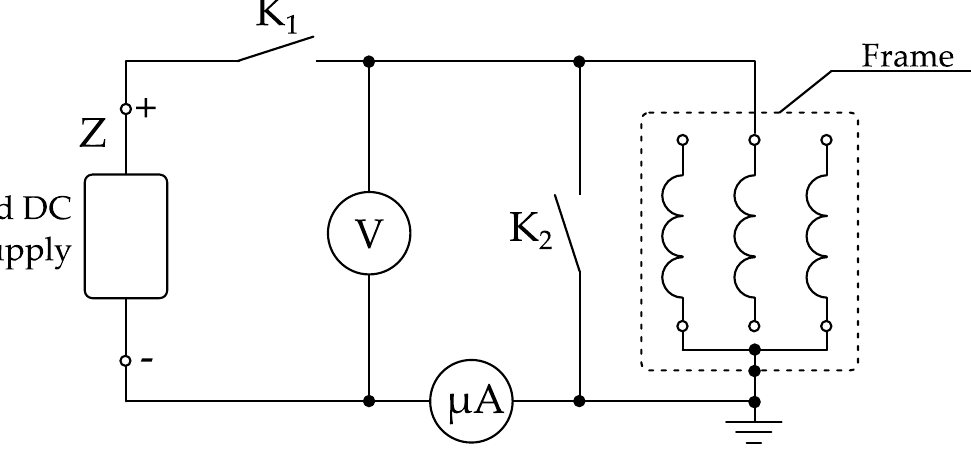
Figure 8. Scheme of the measuring system for the WMPS method.